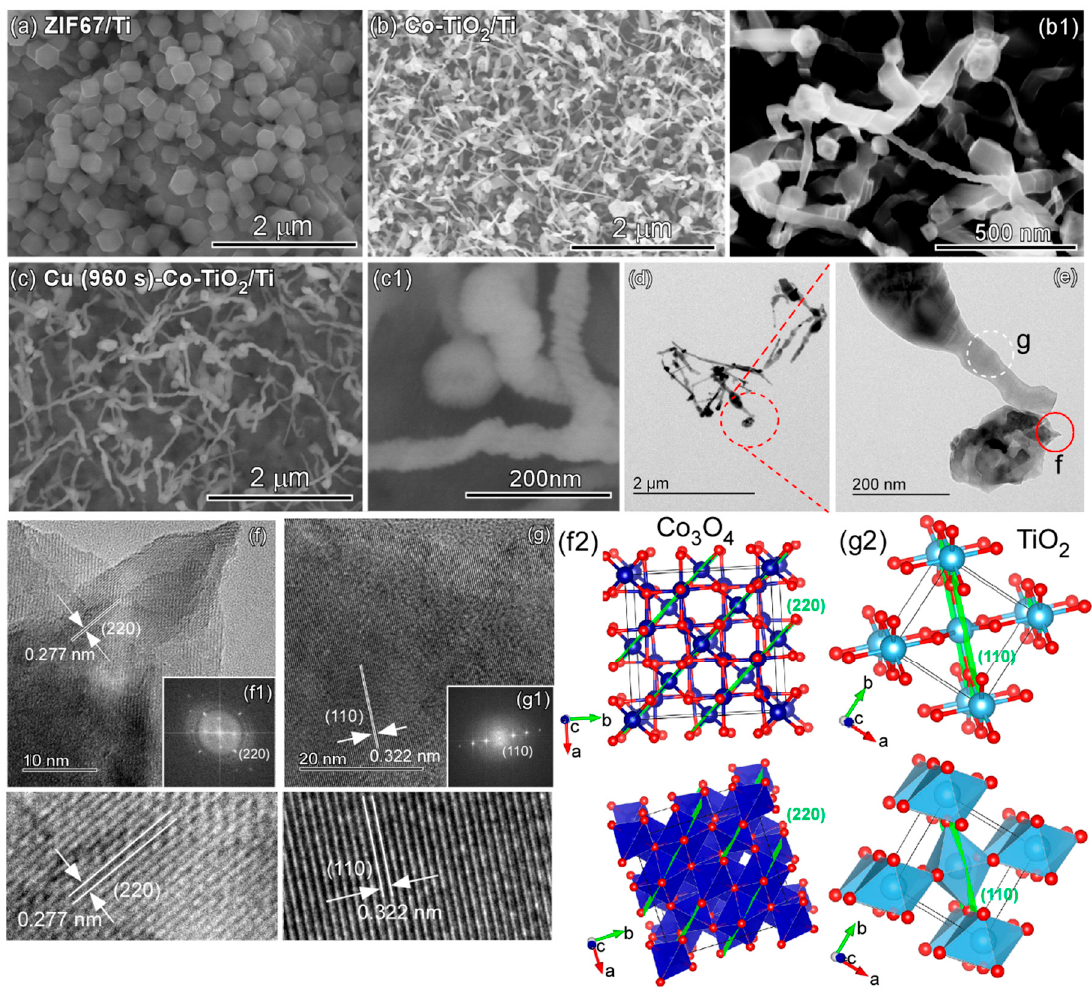
Figure 3. SEM images of ZIF67-Ti ( a ), Co-TiO 2 /Ti ( b , b1 ), Cu (960 s)-Co-TiO 2 /Ti ( c , c1 ). TEM ( d , e ) and HRTEM ( f , g ) images of Co-TiO 2 /Ti. Insets show the corresponding FFT patterns ( f1 , g1 ) and the structure projection ( f2 , g2 ) of the (220) and (110) planes for Co 3 O 4 ( f2 ) and rutile TiO 2 ( g2 ), respectively.